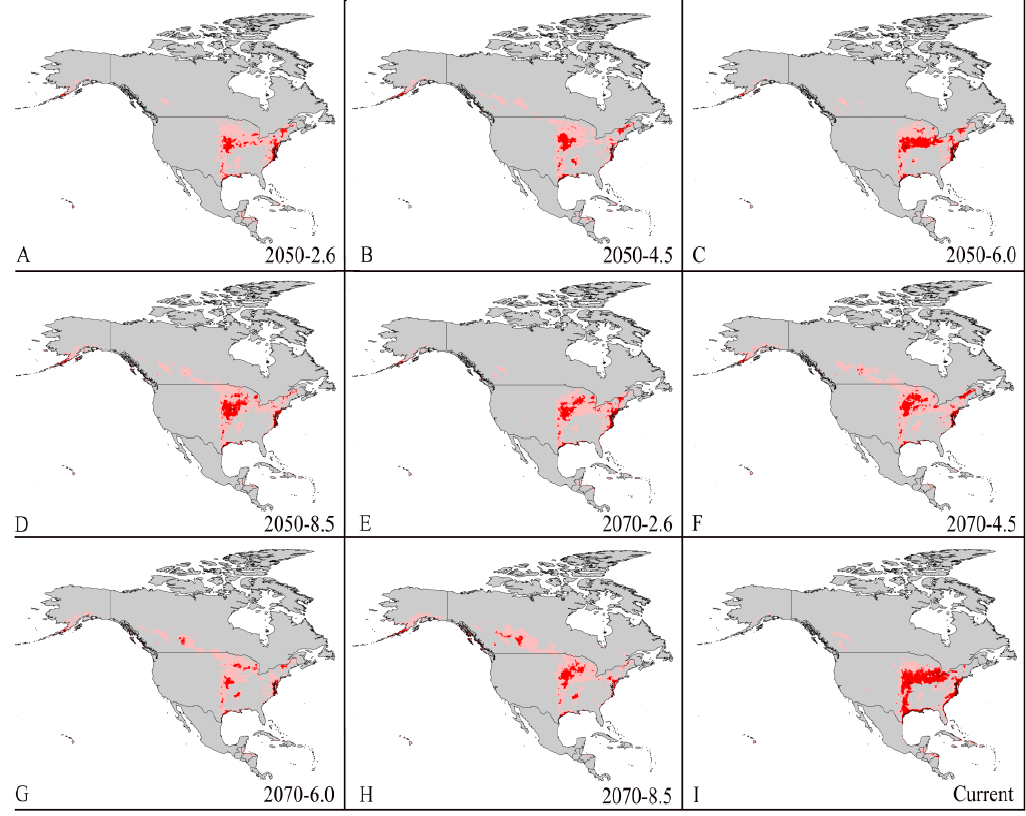
Figure 6. Future potential suitable habitats of Pseudaulacaspis pentagona on the North America continent under di ff erent climate scenarios predicated by MaxEnt. Gray, unsuitable habitat area; Pale red, low habitat suitability area; Red, moderate habitat suitability area; Dark red, high habitat suitability area. ( A ) RCP 2050-2.6; ( B ) RCP 2050-4.5; ( C ) RCP 2050-6.0; ( D ) RCP 2050-8.5; ( E ) RCP 2070-2.6; ( F ) RCP 2070-4.5; ( G ) RCP 2070-6.0; ( H ) RCP 2070-8.5; ( I ) Current.